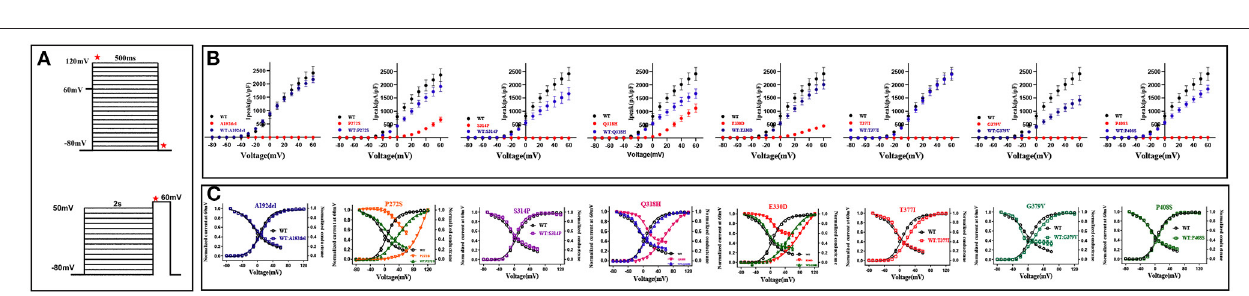
FIGURE 1 | Averaged whole-cell current density traces of CHO-K1 transiently expressing MOCK or KCNB1 subunits.